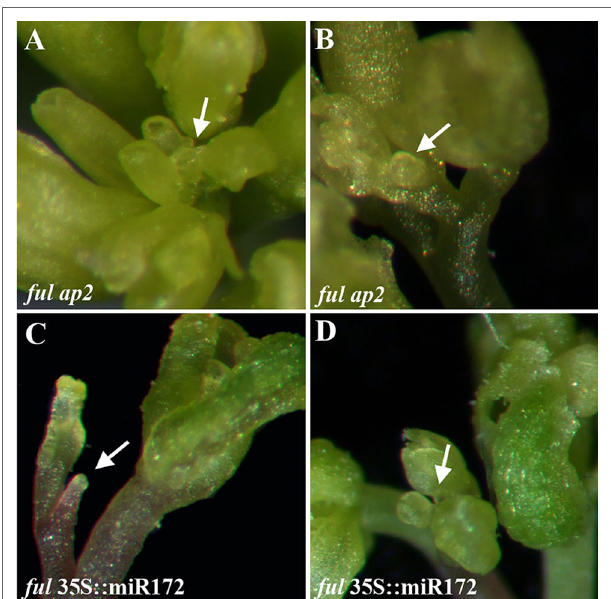
FIgURe 5 | Terminal flower formation in the absence of AP2-like activity is dependent on FUL. The inflorescence meristem determination into a terminal structure observed in the ap2–12 single mutant is suppressed by ful mutations (a , B) . In the 35S::miR172 plants, where the levels all the AP2-like genes are reduced and the terminal flower is formed very early in inflorescence development, the ful mutation also suppresses its formation (c , D) .